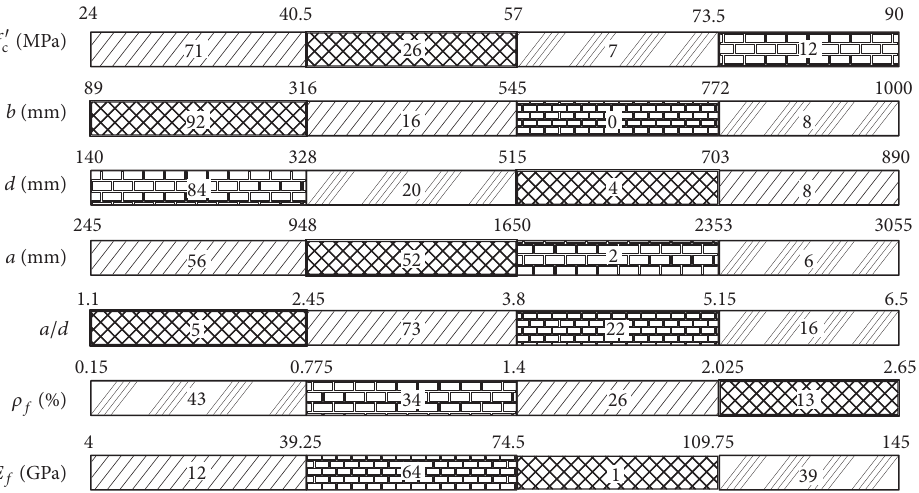
Figure 2: Data distribution of experimental parameters.